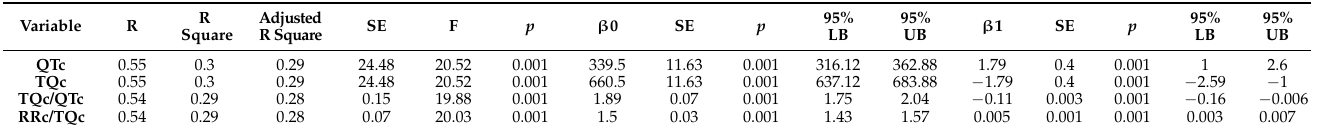
Table 4. Model summary, ANOVA report, and coefficients for simple linear regression analysis—BFP versus electrical ventricular parameters ( n =